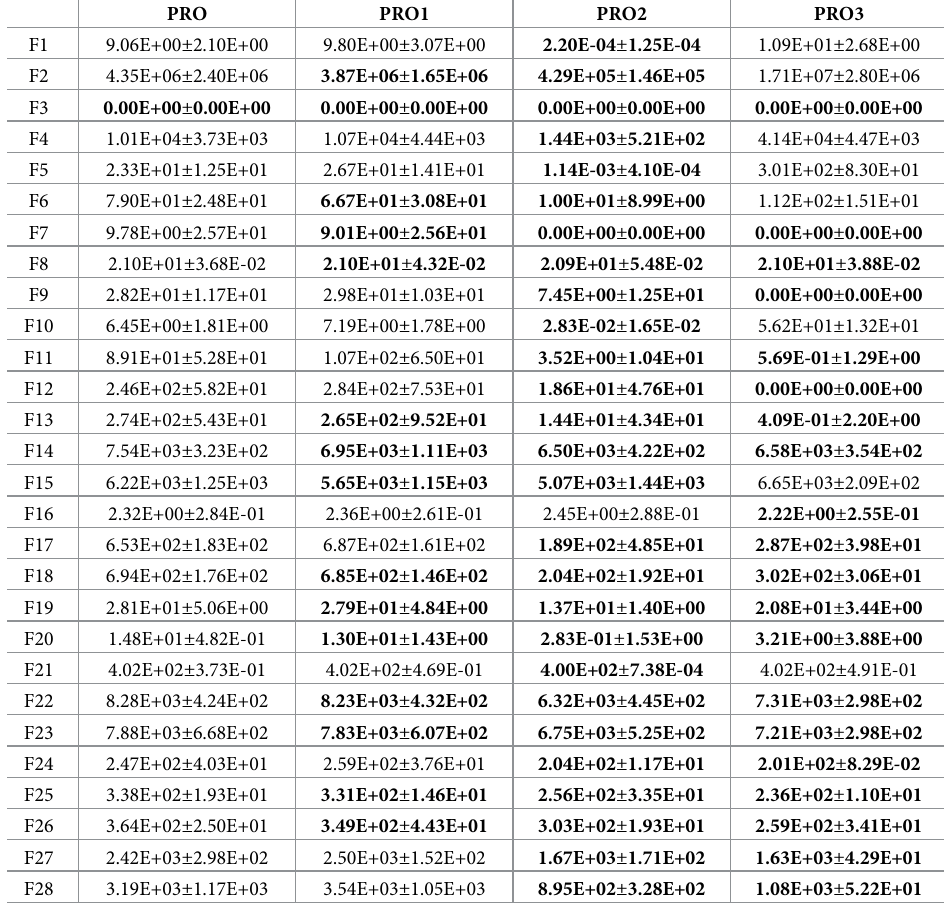
Table 3. Comparison results of each improved strategy on the 30-dimensional CEC2013 test